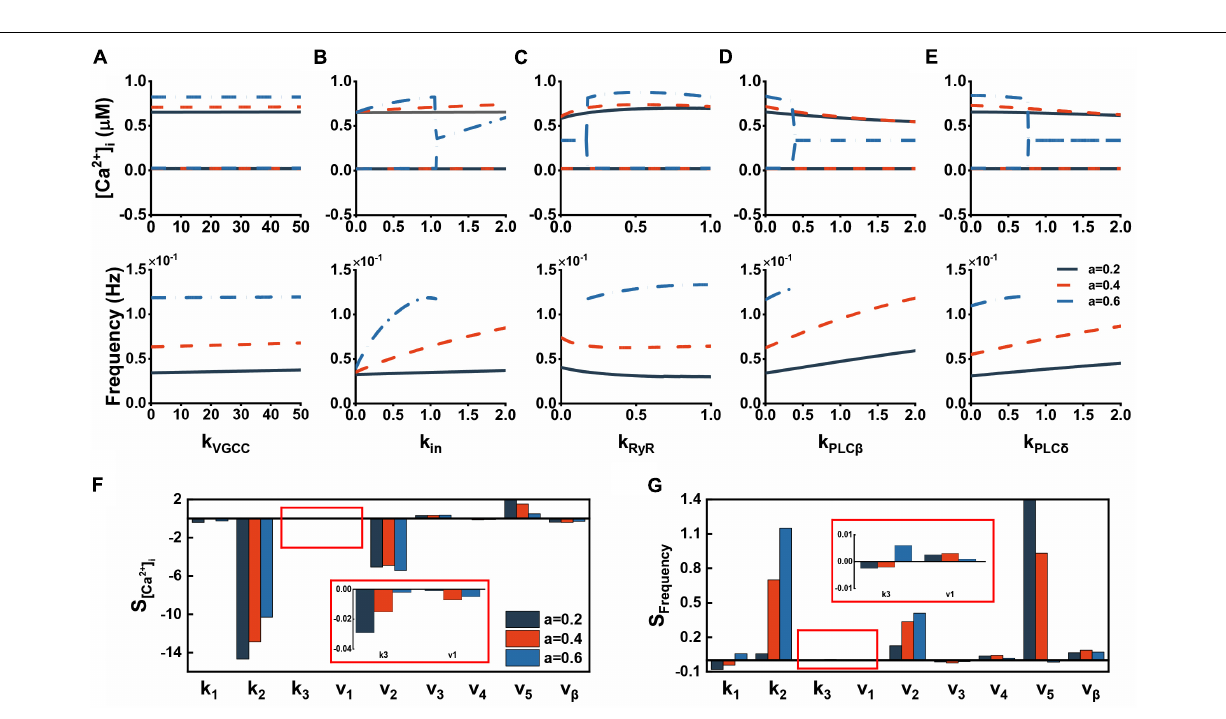
FIGURE 3 | The effect of various parameters on cytosolic Ca 2 + dynamics. (A–E) Bifurcation diagrams of [Ca 2 + ] i plotted against the strength of A β acting on different pathways. (F) Amplitude sensitivity of Ca 2 + dynamics. The sensitivities are calculated for parameter variations of ± 10%. (G) Frequency sensitivity of Ca 2 + dynamics. The sensitivities are calculated for parameter variations of ±